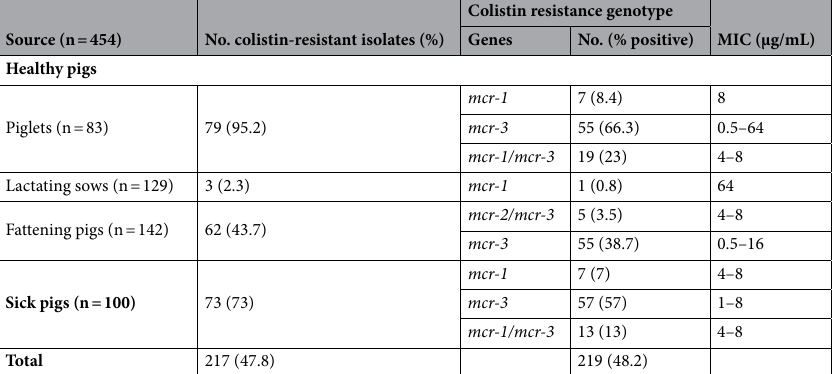
Table 2. Colistin resistance phenotype and genotype in E. coli isolates (n = 454) in Thailand between 2007 and